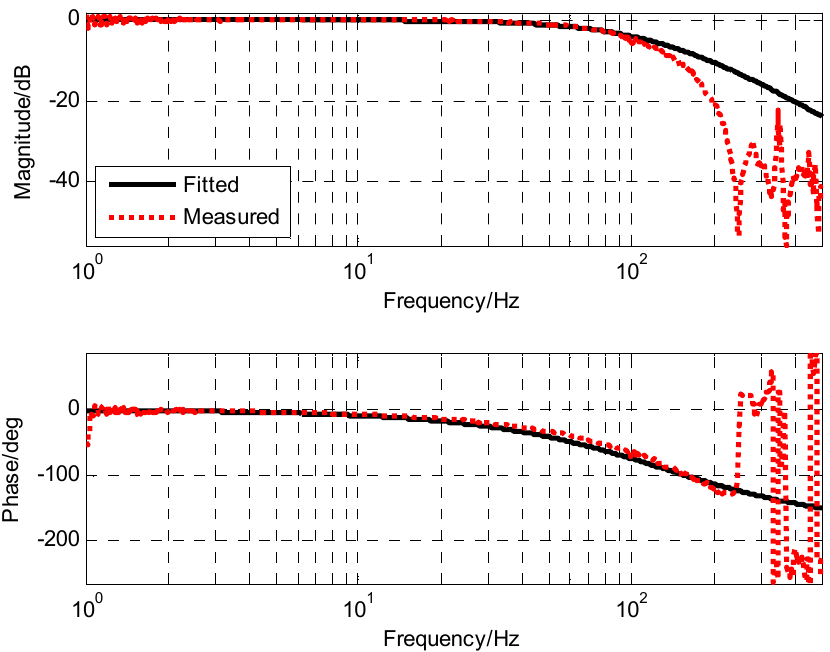
Figure 9. The frequency characteristic of filtered MEMS gyro (PSD as reference sensor).